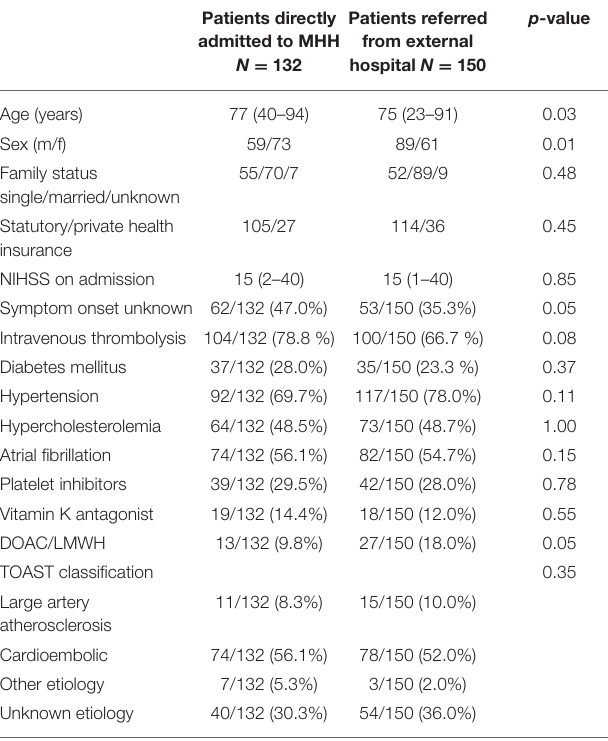
TABLE 1 | Baseline characteristics of patients directly admitted to MHH vs. patients referred from external hospitals. Patients directly admitted to